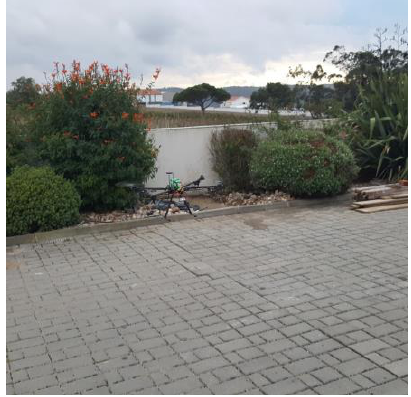
Figure 6. UAV facing the “Impact zone”.